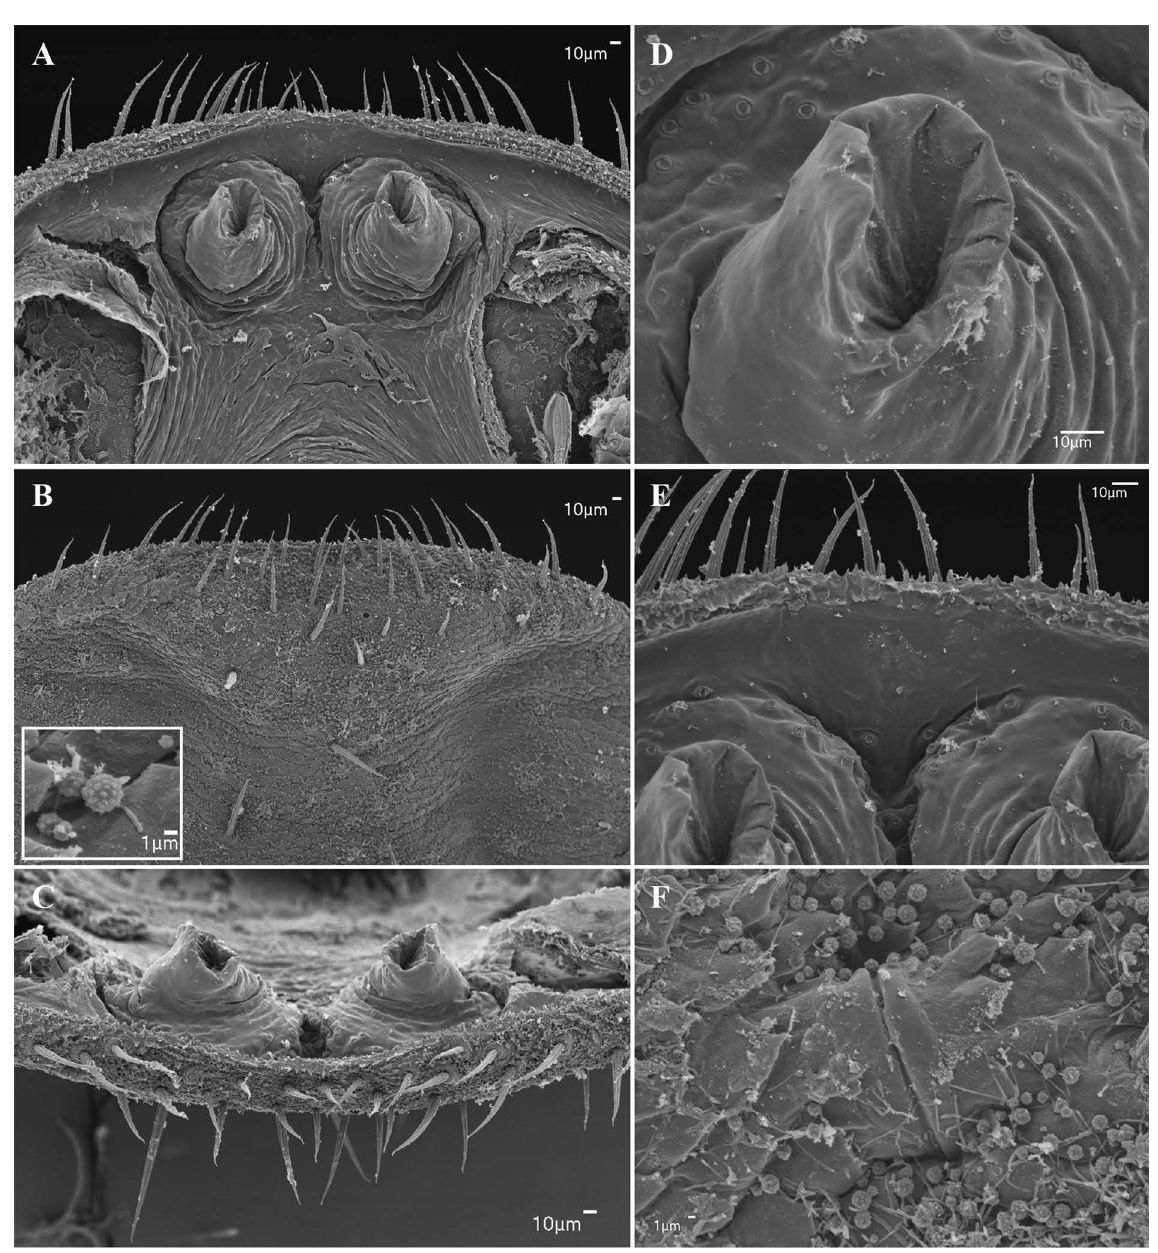
Fig. 79. Charinus una sp. nov. (MNRJ 9131), female gonopod and genital operculum. A . Sucker-like gonopod, dorsal view. B . Genital operculum, ventral view. Inset: cerotegument. C . Gonopods, posterior view. D . Aperture on sinistral side of sucker-like gonopod, dorsal view. E . Posterior margin of genital operculum. F . Gland opening near lateral margin of